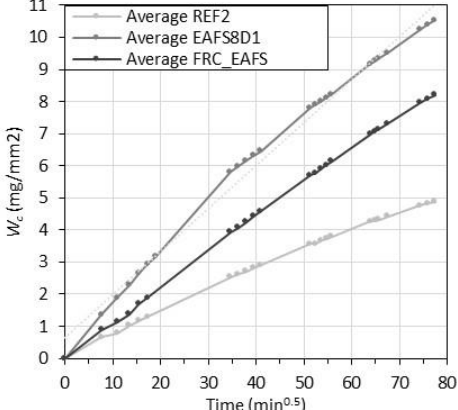
Figure 19. Results of water absorption by capillarity for REF2, EAFS8D1 and FRC_EAFS mixtures.